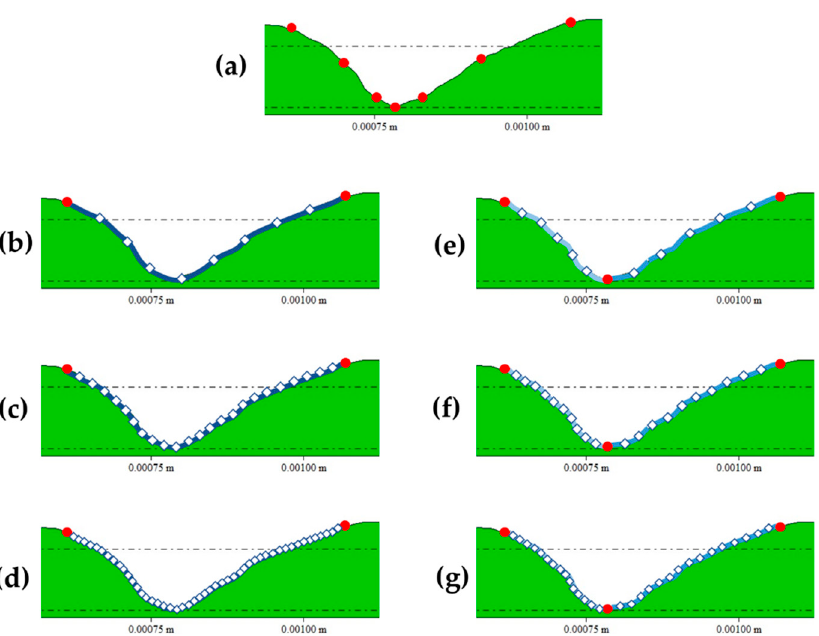
Figure 1. Landmark and semilandmark models created for the present study on an example of a leopard score cross-sectional profile, where fixed landmarks are red and semilandmarks are white. ( a ) corresponds to the 7-landmark model; ( b ) to the 10 semilandmark-model slid on a single curve; ( c ) to the 25 semilandmark-model slid on a single curve; ( d ) to the 50 semilandmark-model slid on a single curve; ( e ) to the 10 semilandmark-model slid on two curves defined by three fixed points; ( f ) to the 20 semilandmark-model slid on two curves defined by three fixed points; and ( g ) to the 30 semilandmark-model slid on two curves defined by three fixed points.